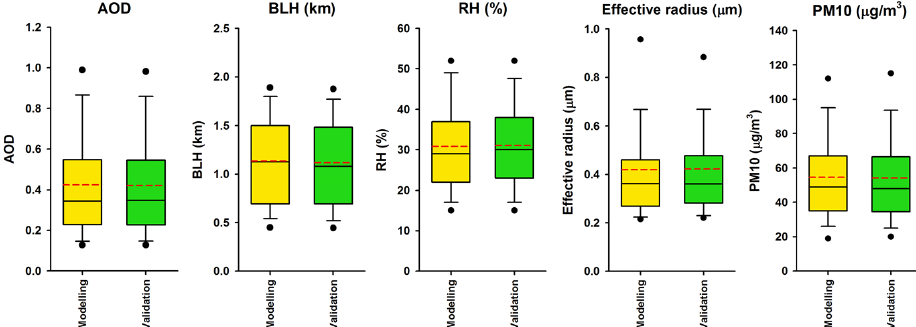
Figure 5. The distribution (5, 10, 25%, median, 75, 90, and 95%) of AOD, boundary layer height (BLH), relative humidity (RH), effective radius, and PM 10 concentrations in the modeling and validation groups derived from AERONET data sets collected during the DRAGON- Asia campaign in Seoul. The red dashed line in the plot denotes the mean value.